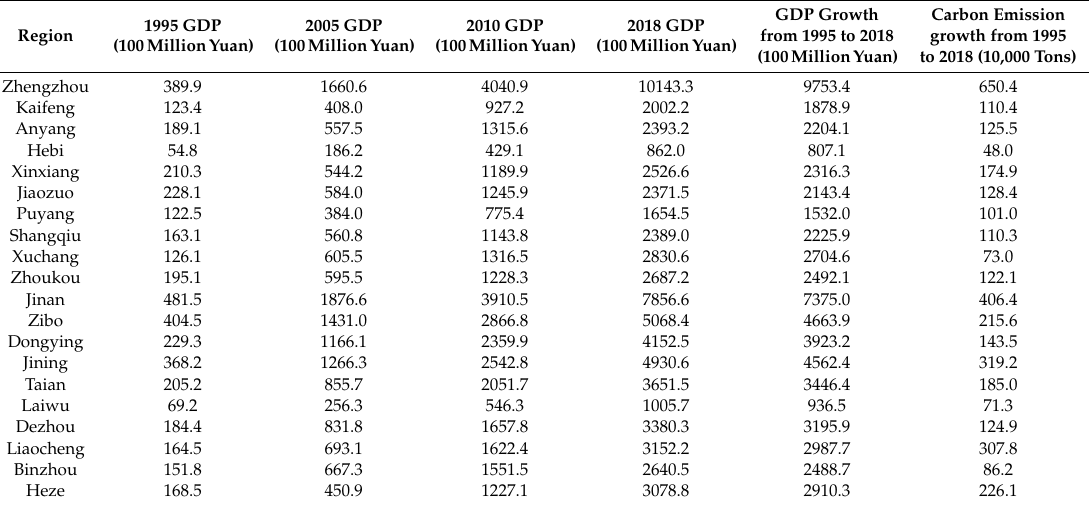
Table 4. Gross Domestic Product (GDP) growth and growth rates of prefecture-level cities from 1995 to